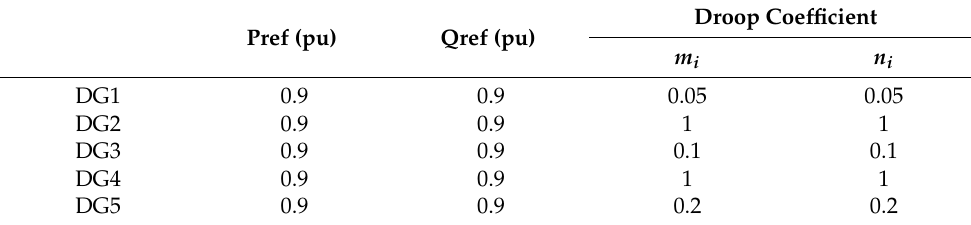
Table 3. Control parameters of DG.